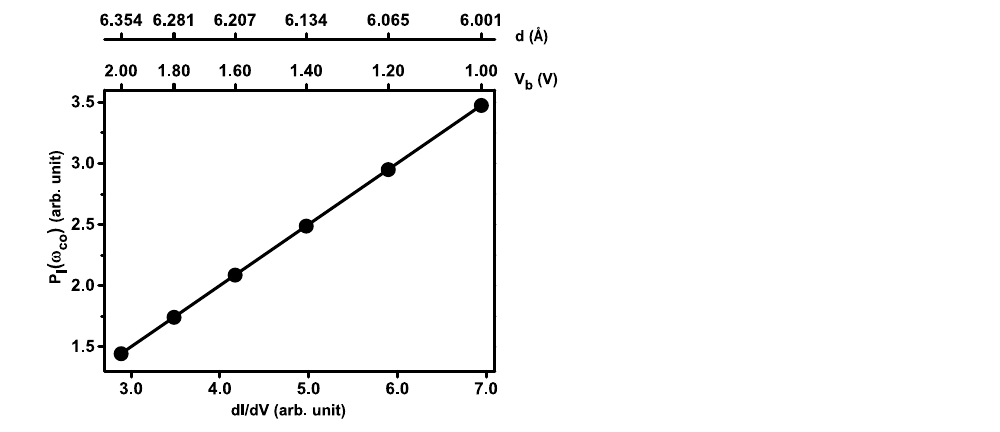
Figure 5. Variation of residual P I ( ω co ) with junction conductance. Top x axes gives the corresponding values of V b and tunnel gap d